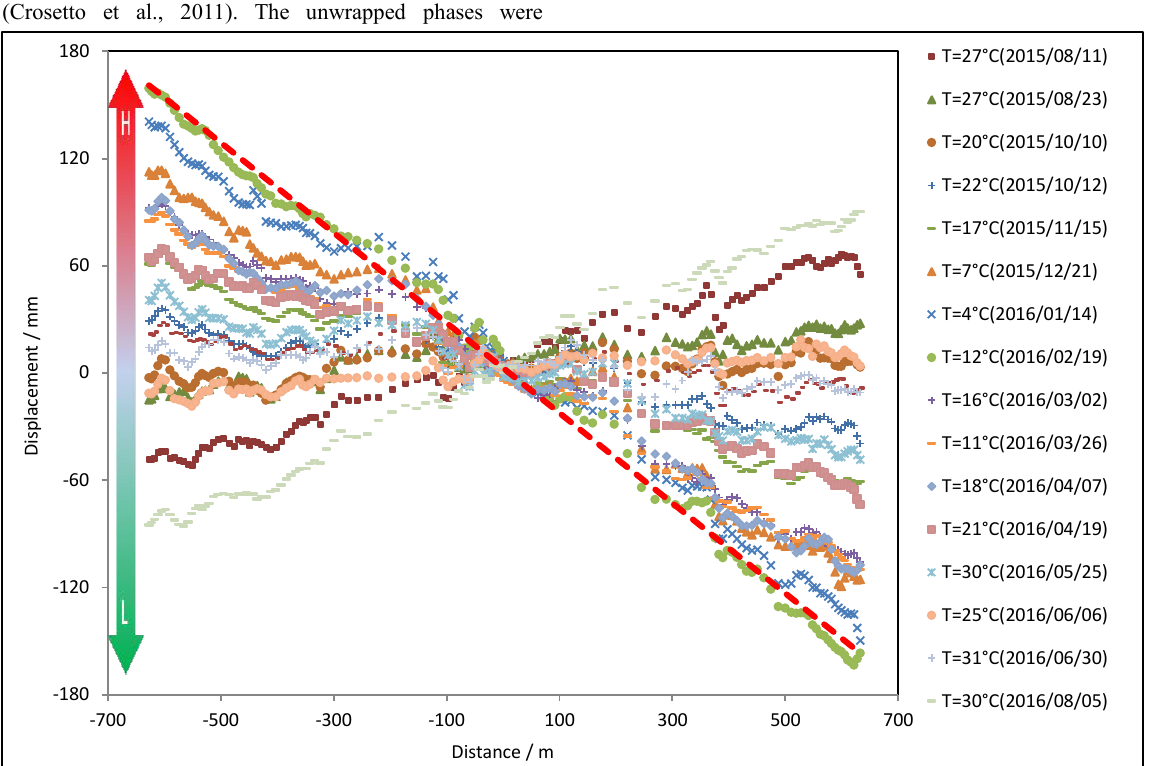
Figure 6: Longitudinal displacements measured along the bridge. Figure 6: s hows the longitudinal displacements time